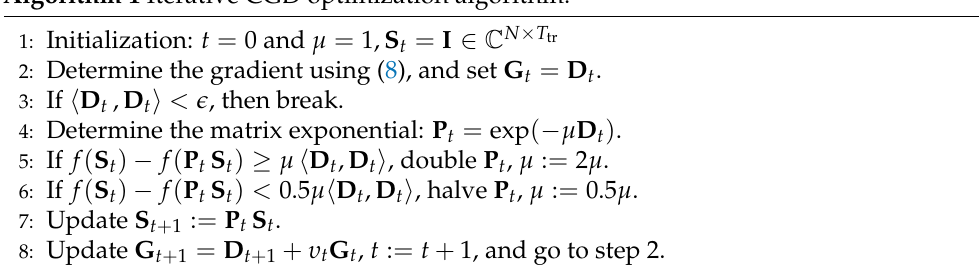
Algorithm 1 Iterative CGD optimization